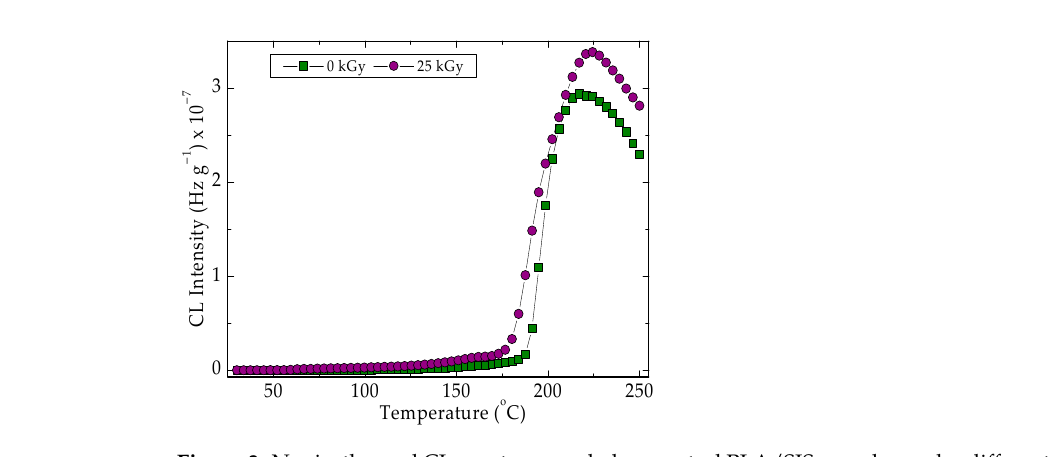
Figure 3. Nonisothermal CL spectra recorded on control PLA/SIS samples under different irradiation state. Heating rate: 3.7 °C min − 1 .